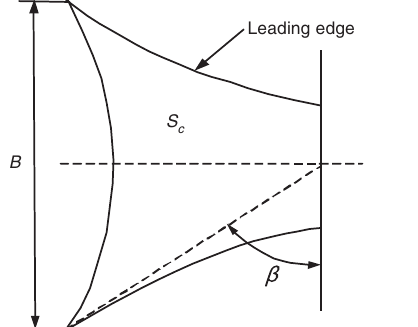
Figure 1 Configuration of caudal fin.